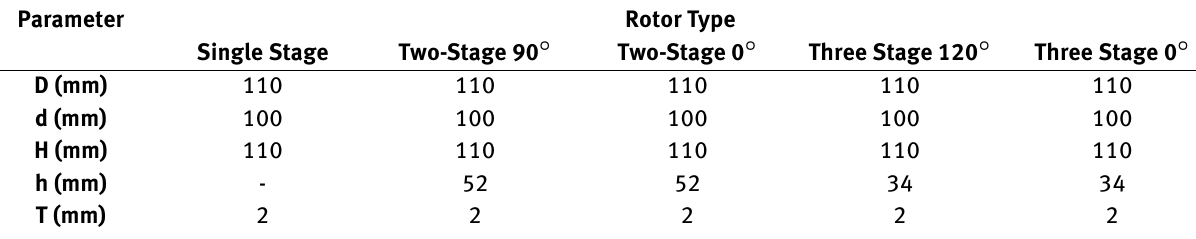
Table 1: The dimension of the rotor.